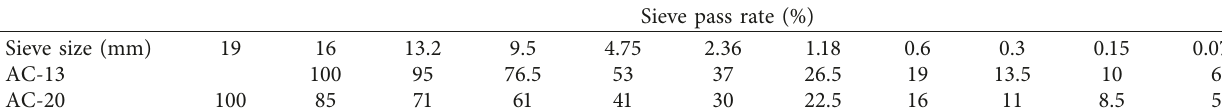
Table 1: Gradation of the aggregate for asphalt mixture.